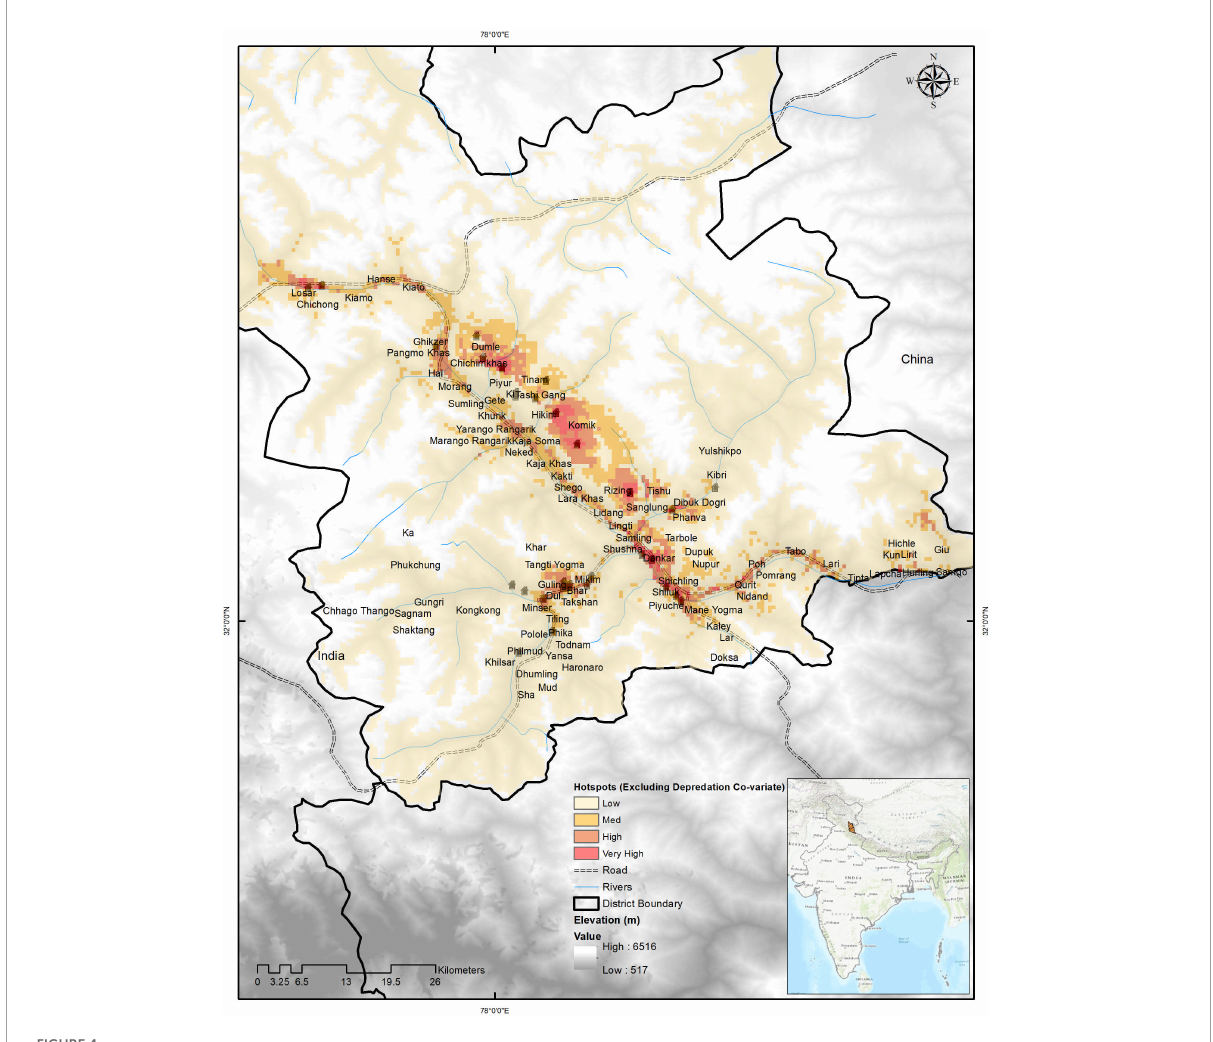
FIGURE4 Wolf predation hotspots when all prey data is included from scats of all prey combined. The very high predation zone is 34 km 2 , the high predation zone is 89 km 2 , the medium predation zone is 239 km 2 , and the low predation zone was 3,569 km 2 of the habitable study